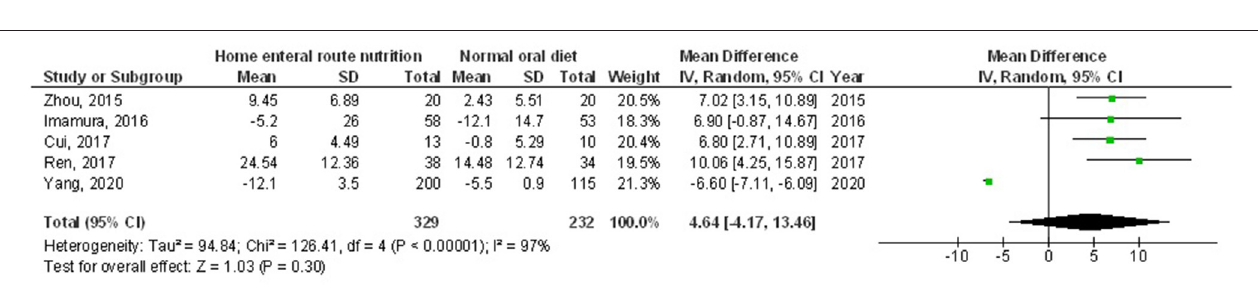
FIGURE 5 | A forest plot of the pre-albumin in subjects with upper gastrointestinal cancer resection with the home enteral nutritional support compared to the normal oral diet.